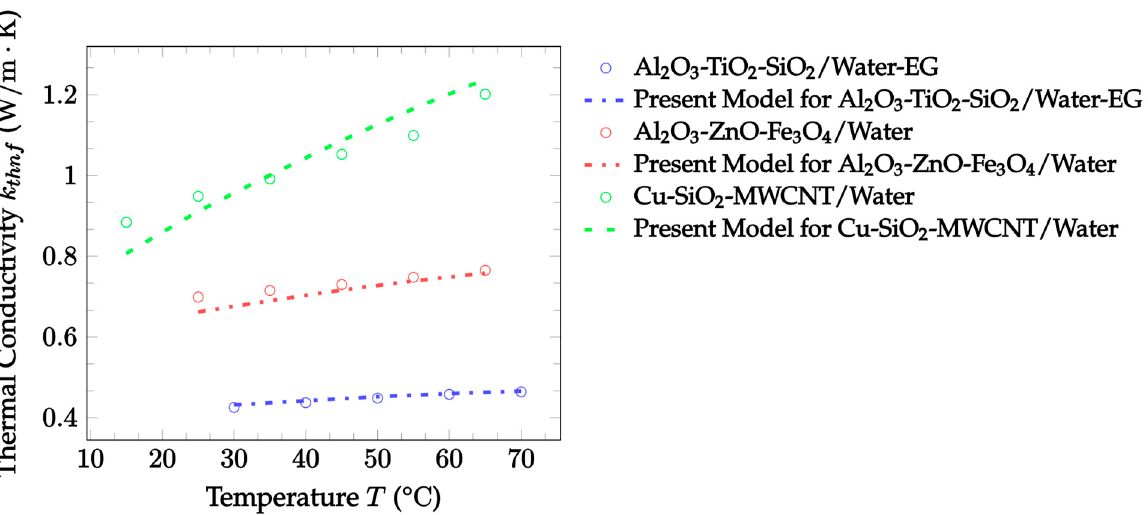
Figure 16. Present model predictions vs. experimental data for ternary hybrid nanofluid. For this figure, predictions at temperature values other than those for experimental data are not accurate: Al 2 O 3 -TiO 2 -SiO 2 /Water–EG [95], Al 2 O 3 -ZnO-Fe 3 O 4 /Water [96], Cu-SiO 2 -MWCNT/Water [97].